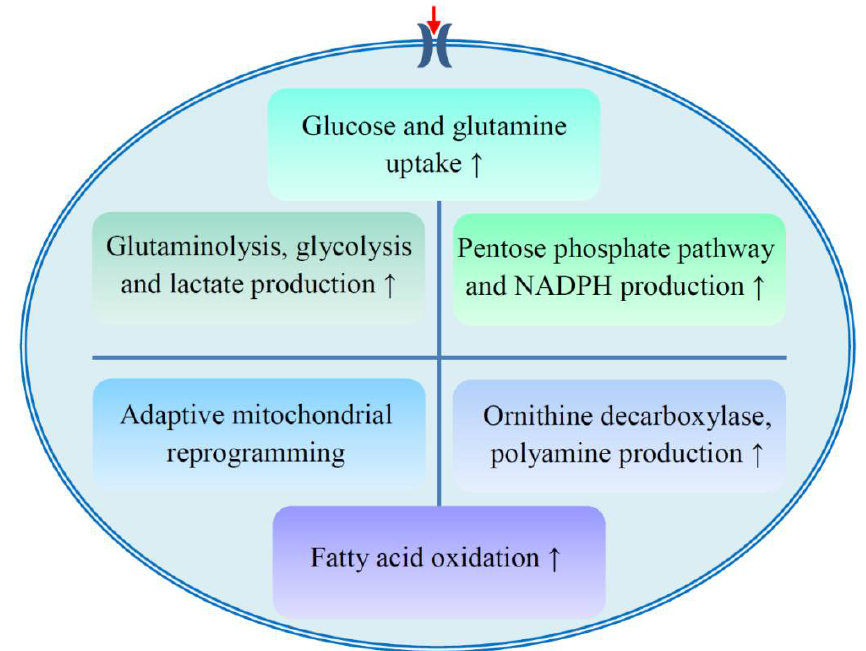
Figure 2. Proposed metabolic mechanisms of drug resistance. The development of drug resistance involves several aspects of metabolism, including the enhancement of glucose and glutamine uptake; active glutaminolysis, glycolysis, pentose phosphate pathway, and fatty acid oxidation; polyamine production; and adaptive mitochondrial reprogramming. NADPH, reduced form of nicotinamide adenine dinucleotide phosphate.